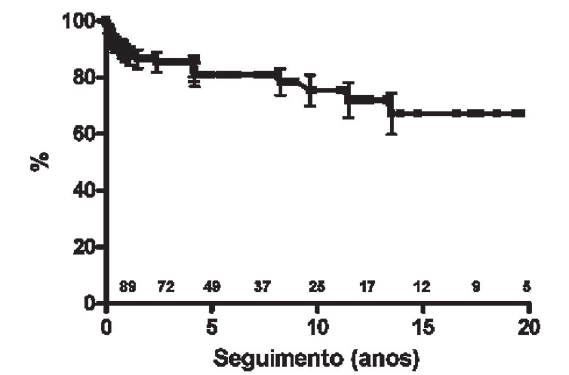
Fig. 1 - Análise, pelo método de Kaplan-Meier, da expectativa